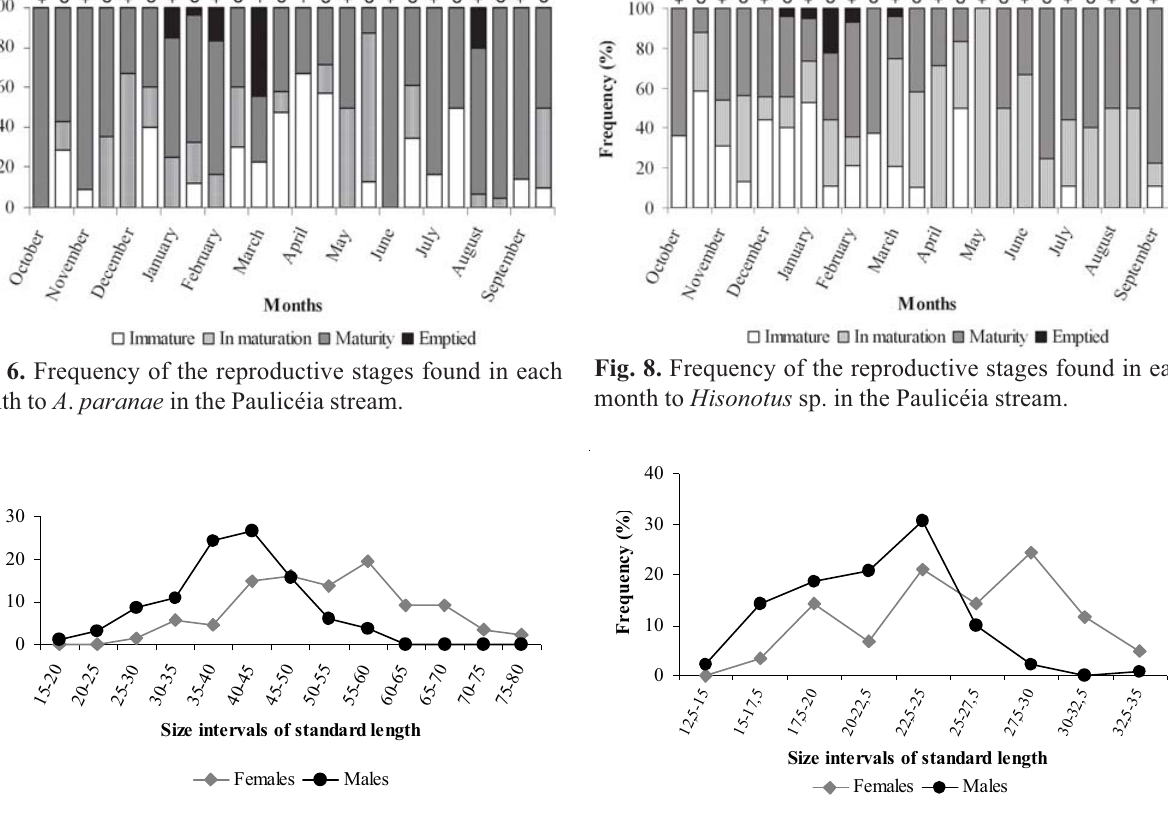
Fig. 9. Sexual proportion of males and females of Hisonotus sp. for each size intervals of the standard length.